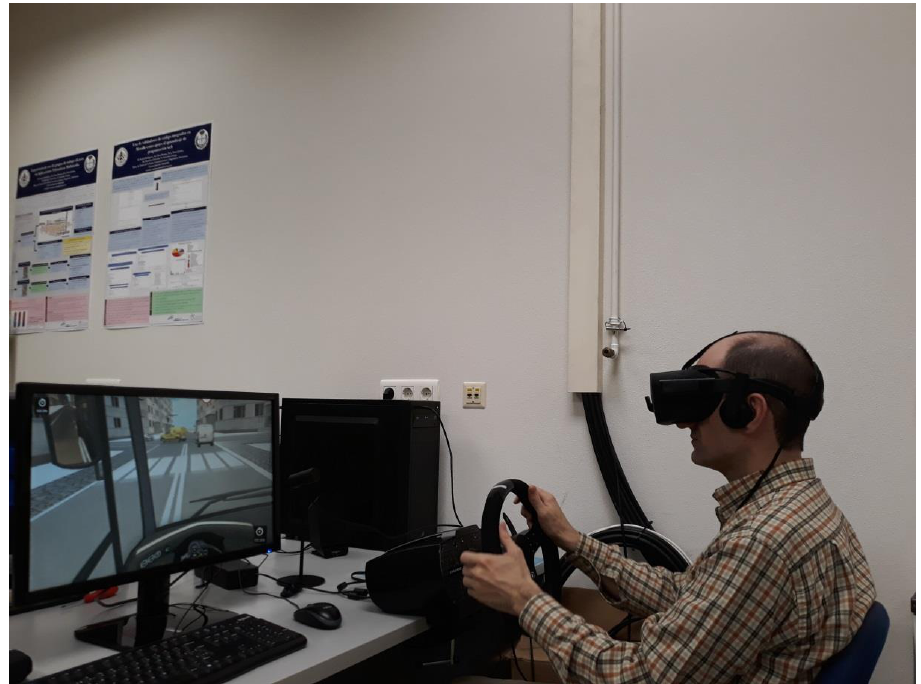
Figure 3. User driving in the simulator with Oculus Rift.